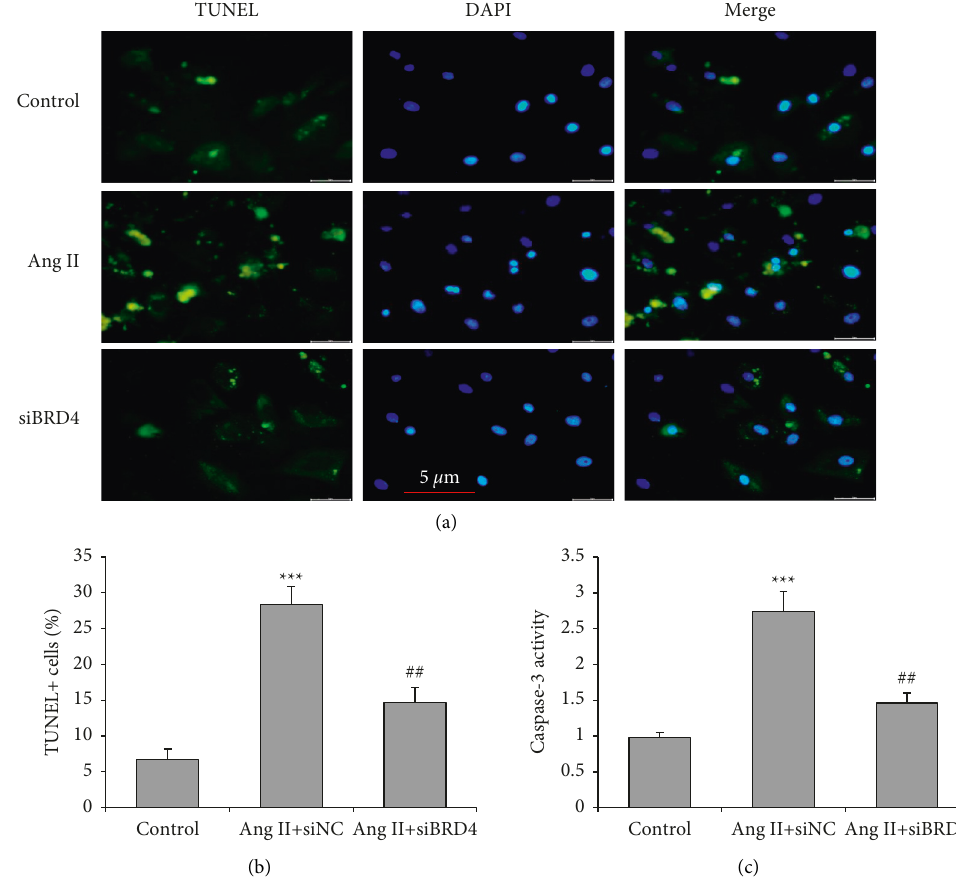
Figure 2: siBRD4 protects H9c2 cells from Ang II-induced apoptosis. H9c2 cells were transfected with siBRD4 or siNC and treated with Ang II (1 μ M) for 48 hours. (a) H9c2 cells were stained with TUNEL to show the apoptotic cells. (b) The number of TUNEL +cells was counted. (c) The caspase-3 activity was determined. Each experiment was performed in triplicate and repeated at least three times. ∗∗∗ P < 0 . 001 vs. control group; ## P < 0 . 01 vs. Ang II+siNC